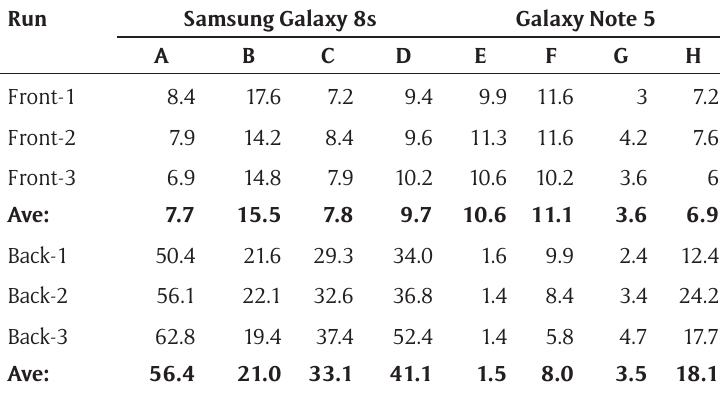
Table 4: Comparison of ground radiation levels measured by multiple Samsung phones.